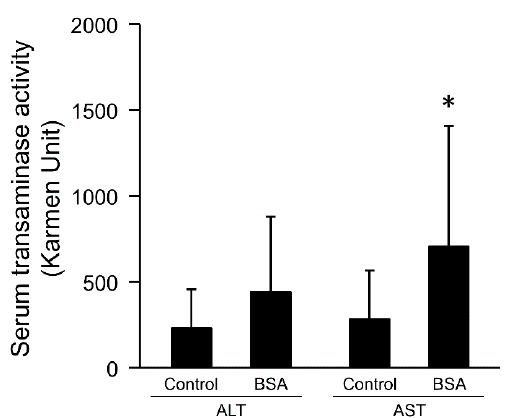
Figure 3. Effect of interaction of lipoplex with albumin on serum transaminase activities 6 h after i.v. injection in hepatitis mice. Lipoplex was incubated with 5% glucose (control) or BSA. Each bar represents the mean + SD of at least 6 experiments. Statistical method, Student’s t -test. * p < 0.05 vs. control.